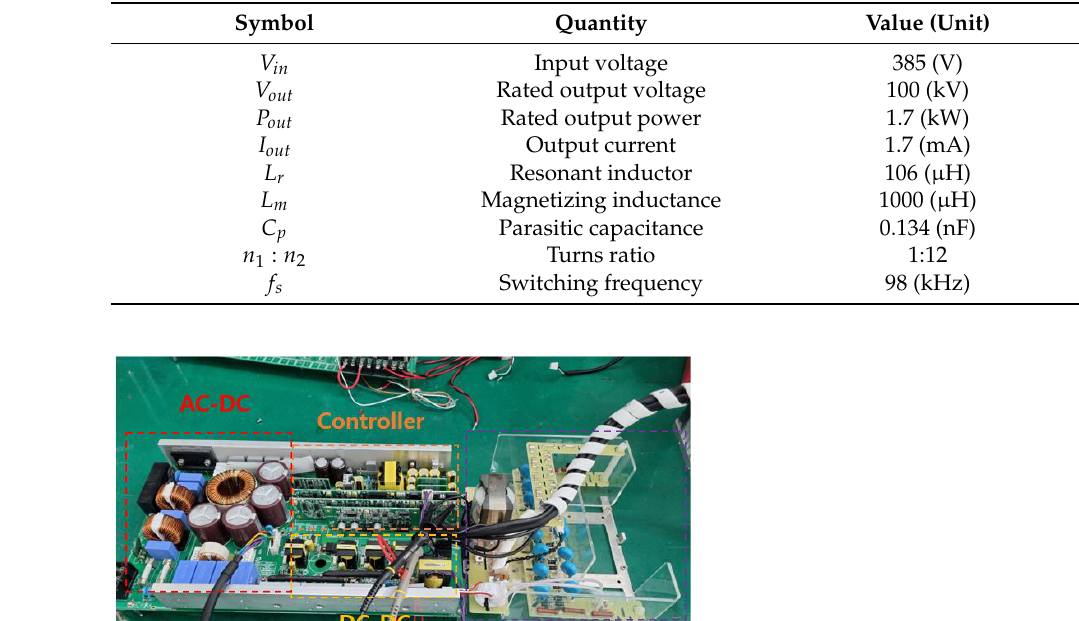
Table 1. System parameters.